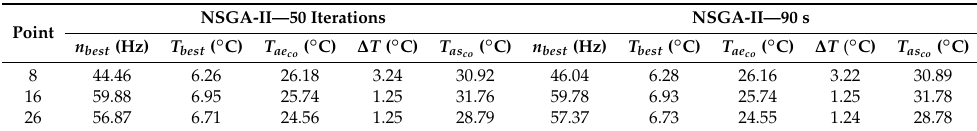
Table 7. Verification of compliance of NSGA-II with the operational restrictions of the equipment for the 3 operational points.